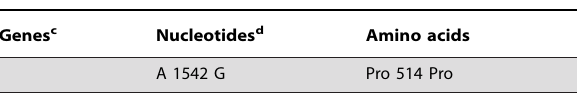
The PTR1 nucleotide sequences of the four L. tropica isolated from Canadian soldiers revealed the presence of single nucleotide polymorphisms (SNPs) at five different positions (Table 1). The changes in nucleotide were conservative (Table 1), and the same polymorphisms were also observed in two other strains of L. tropica (strains 482 and MHOM/SU/74/K27) that we have analyzed (Table 2). The heterozygous gene sequences were detected as split peaks in the chromatogram generated by the sequencing of the PTR1 locus in both directions, using DNA extracted from populations of parasites. This type of polymorphism was not observed when sequencing the PTR1 gene of L. infantum and L. major (Table 2). To